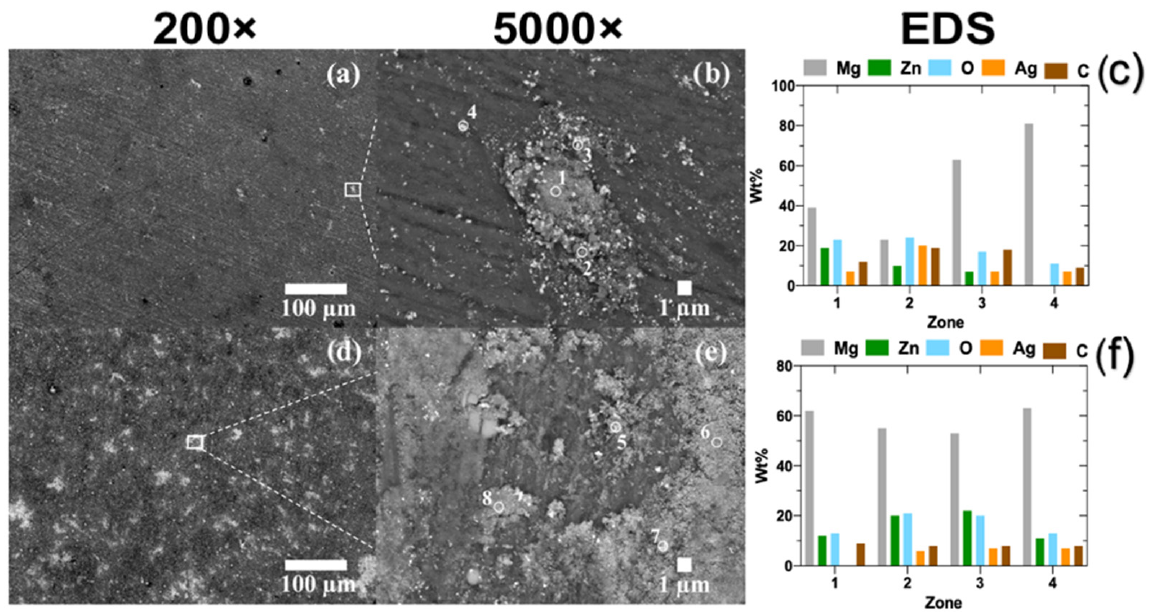
Figure 9. SEM images (200 × and 5000 × ) and EDS analysis of electroless ZnO/Ag hybrid deposits achieved on ZnO/Mg–Ca0.3 surfaces obtained from aqueous solutions (10 − 3 M, at 21 °C): ( a – c ) ZnO/AgNO 3 and ( d – f ) Zn(NO 3 ) 2 /AgNO 3 .